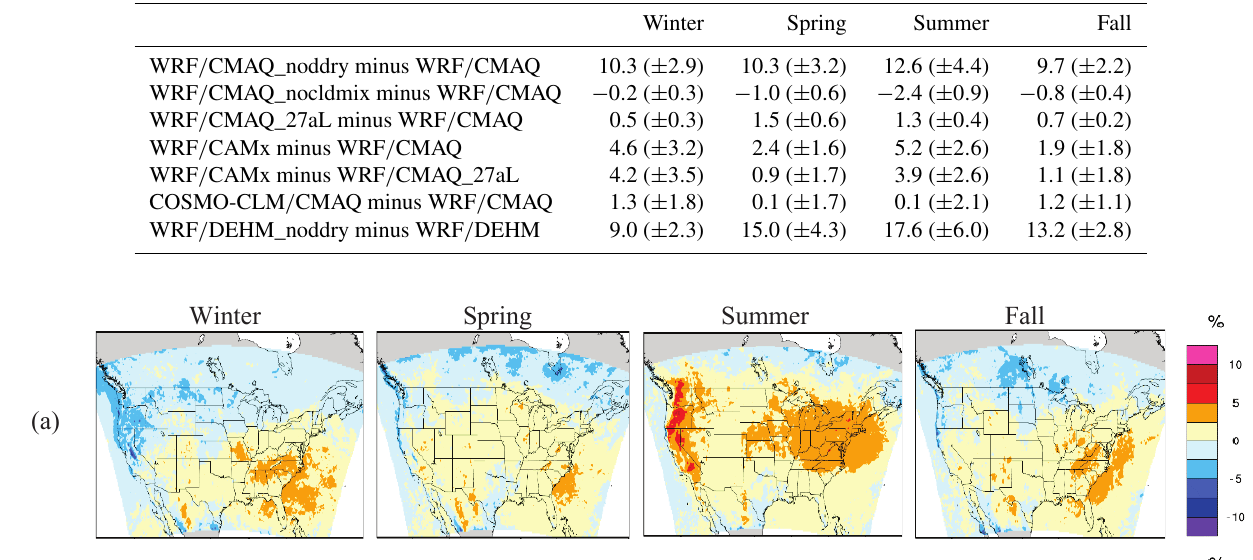
Table 3. Differences in seasonal averaged DM8A BCT (ppb) between simulations after averaging over all land grid cells over the analysis domain. Values in parentheses are the standard deviations of the differences between simulations over land.